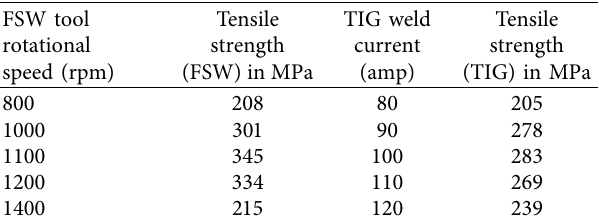
Table 2: Tensile strength of fabricated weld joints. FSW tool